Question: According to the figure, is the described quantity increasing or decreasing?
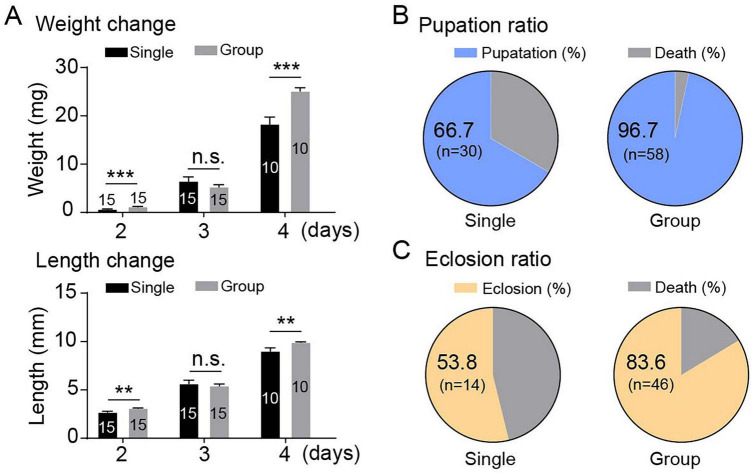
Answer: increasing